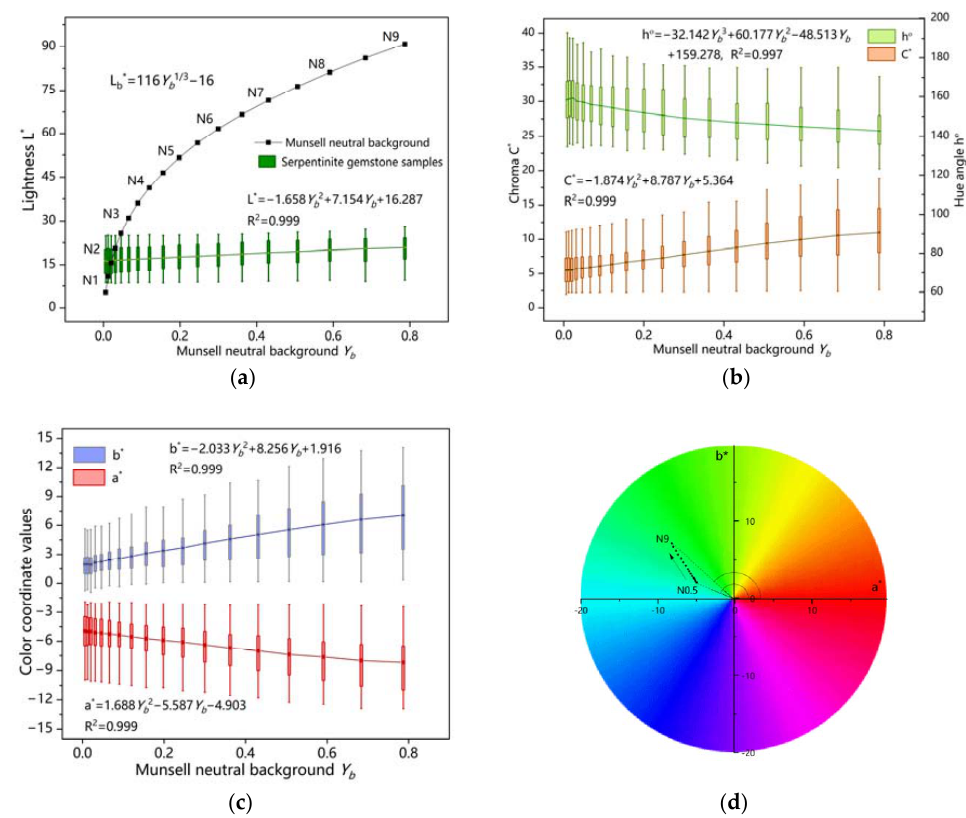
Figure 6. Changes in the color of serpentine jade samples produced by changes in the Munsell neutral background under D65 light source. ( a ) a box diagram of the lightness L* of the samples (and lightness of the background) and the luminance factor; ( b ) a box diagram of the chroma C* (and hue angle h°) and the luminance factor; ( c ) a box diagram of the color coordinates a*, b* and the luminance factor. ( d ) the plane ‐ projection plot of the a* and b* mean values for each of the 36 serpentine jade samples with each background; the hue angle of the samples gradually decreases as the lightness of the background increases. Table 3. Serpentine jade’s color on 18 Munsell neutral backgrounds.